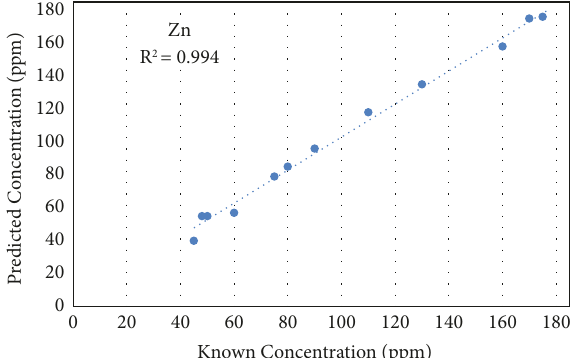
Figure 8: Artificial neural network regression curve of predicted versus known concentration of